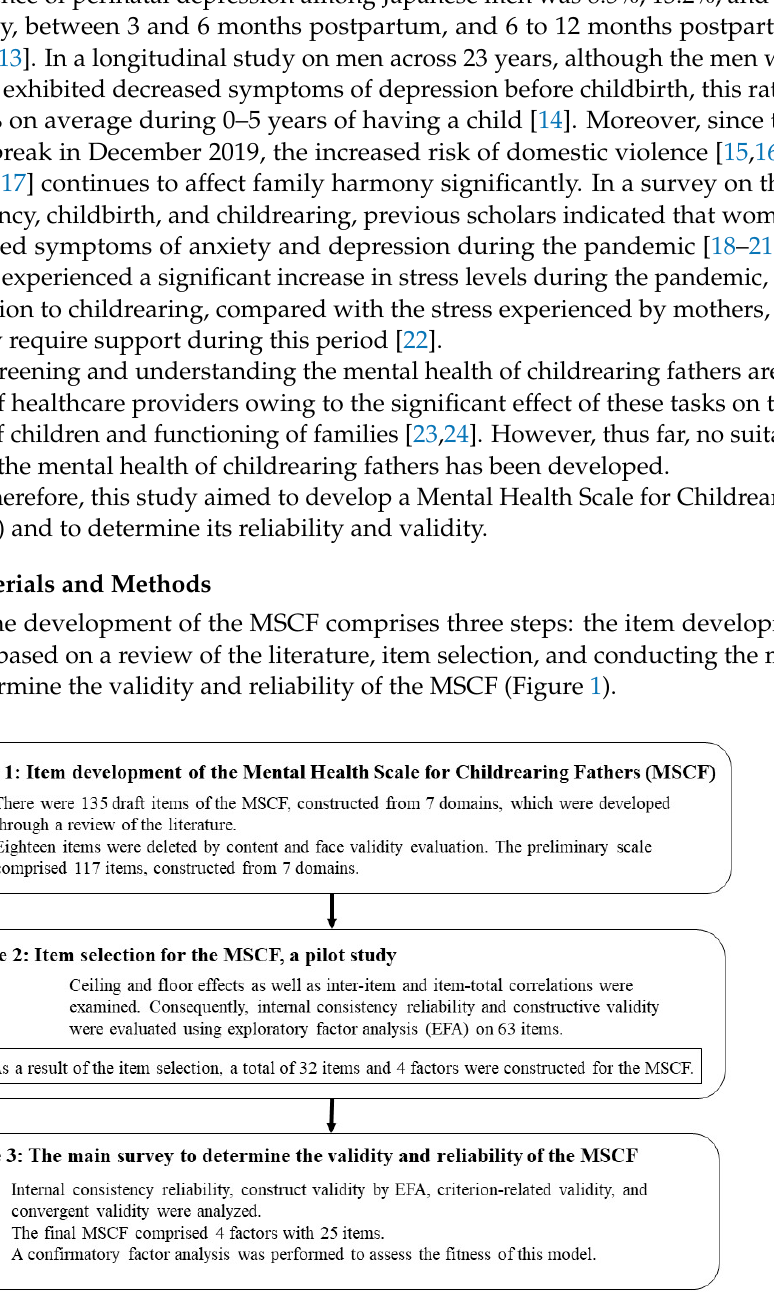
Figure 1. Flow chart for the development of the Mental Health Scale for Childrearing Fathers.